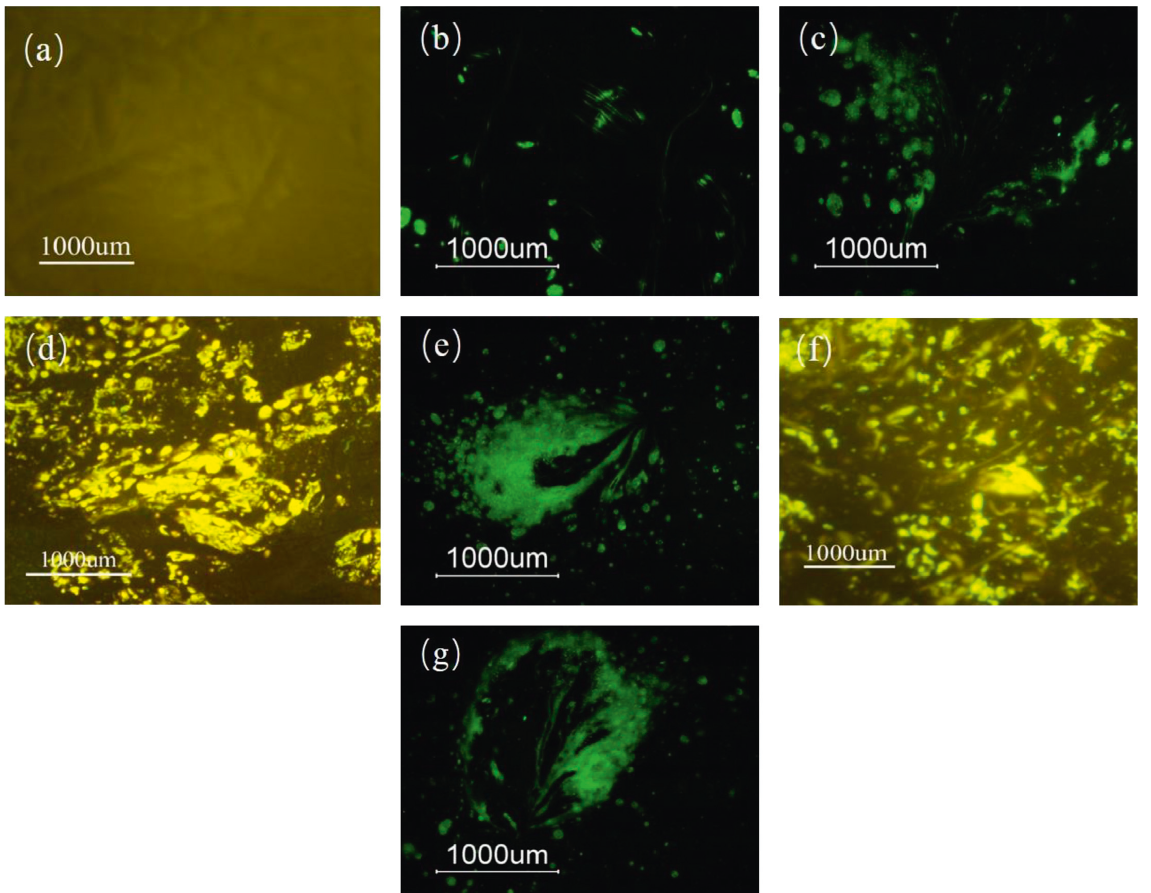
Figure 9: Fluorescence microscope images of the samples: (a) basic asphalt, (b) WPP-modified asphalt with 4 wt. % WPP, (c) WPP/OREC- 0.5-modified asphalt, (d) WPP/OREC-1-modified asphalt, (e) WPP/OREC-1.5-modified asphalt, (f) WPP/OREC-2-modified asphalt, and (g) WPP/OREC-2.5-modified asphalt.